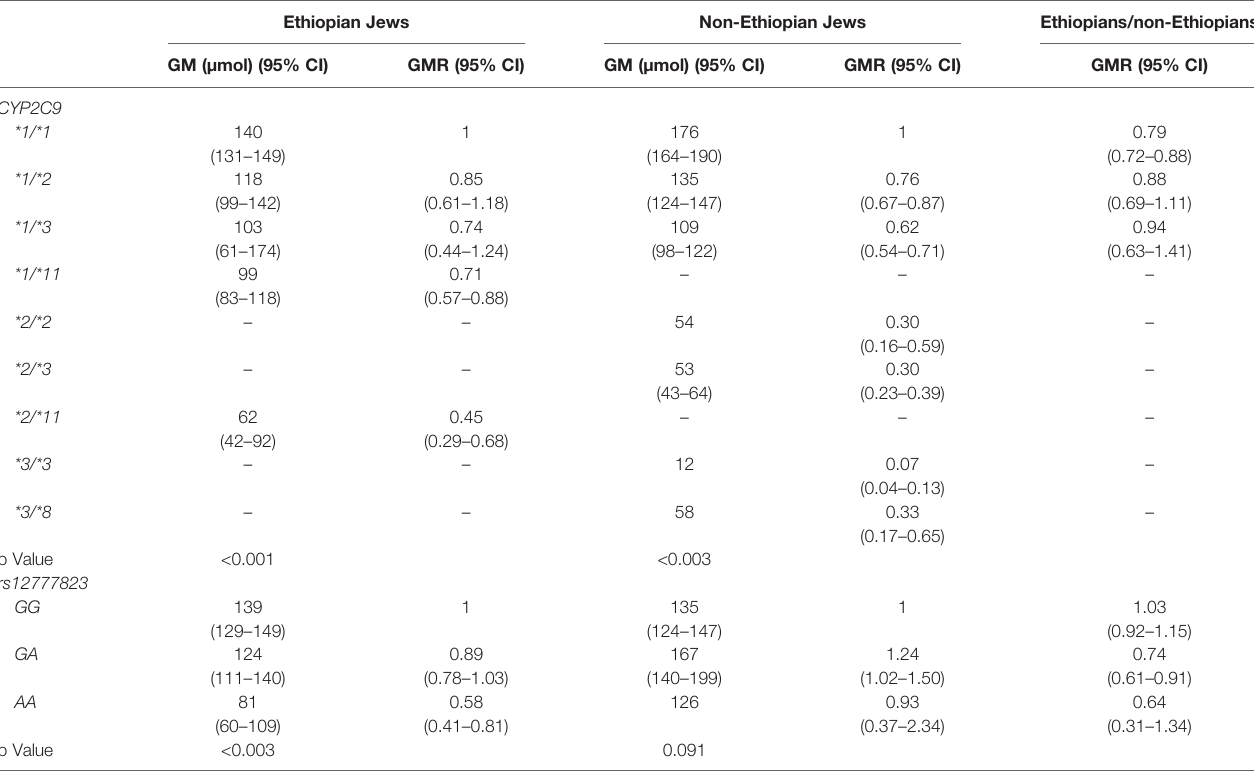
TABLE 3 | Urinary excretion of p-HPPH over 24 h according to CYP2C9 and rs12777823 genotype in the Ethiopian and non-Ethiopian groups. Ethiopian Jews Non-Ethiopian